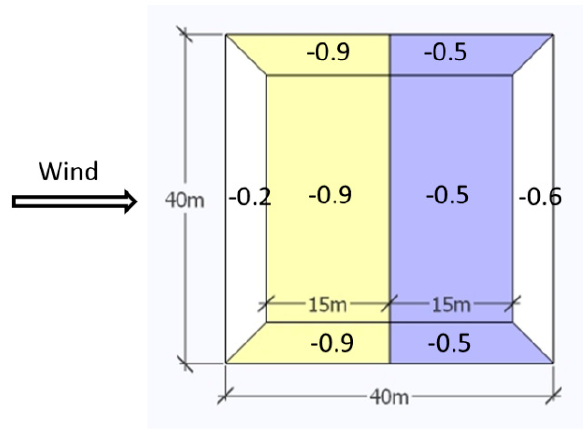
Figure 13. C D 1 for wind loads on facets of a zone of solar array.